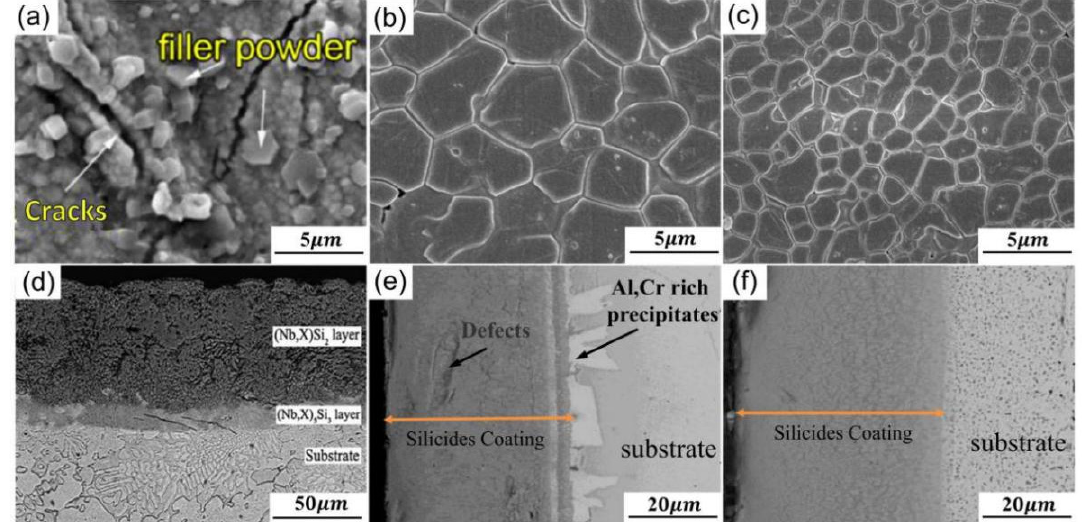
Figure 8. SEM of HAPC coatings: ( a , d ) Al-NbSi 2 coating; ( b , c ) Ge/Ge-Y modified coating; ( e , f ) Effect of different binders BaF 2 /CrCl 3 on coating quality.